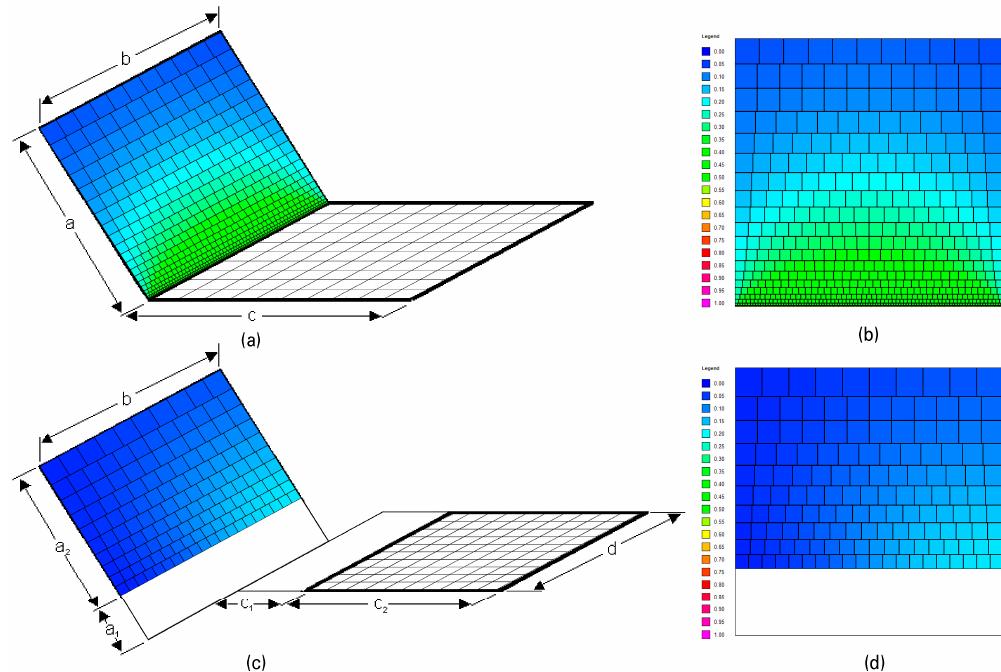
Figure 6. A non-uniform grid, where cells increase in an arithmetic progression, could be applied on ( a ) receiving surface with a common edge with the emitting surface; ( b ) grid for receiving surface with N a = 20 rows of cells; ( c ) receiving surface which is inclined to the emitting surface and they do not share a common edge; and ( d ) grid for receiving surface with N a = 10 rows of cells. The coloured part visualises the VF from the center of each receiving cell to all emitting surface.